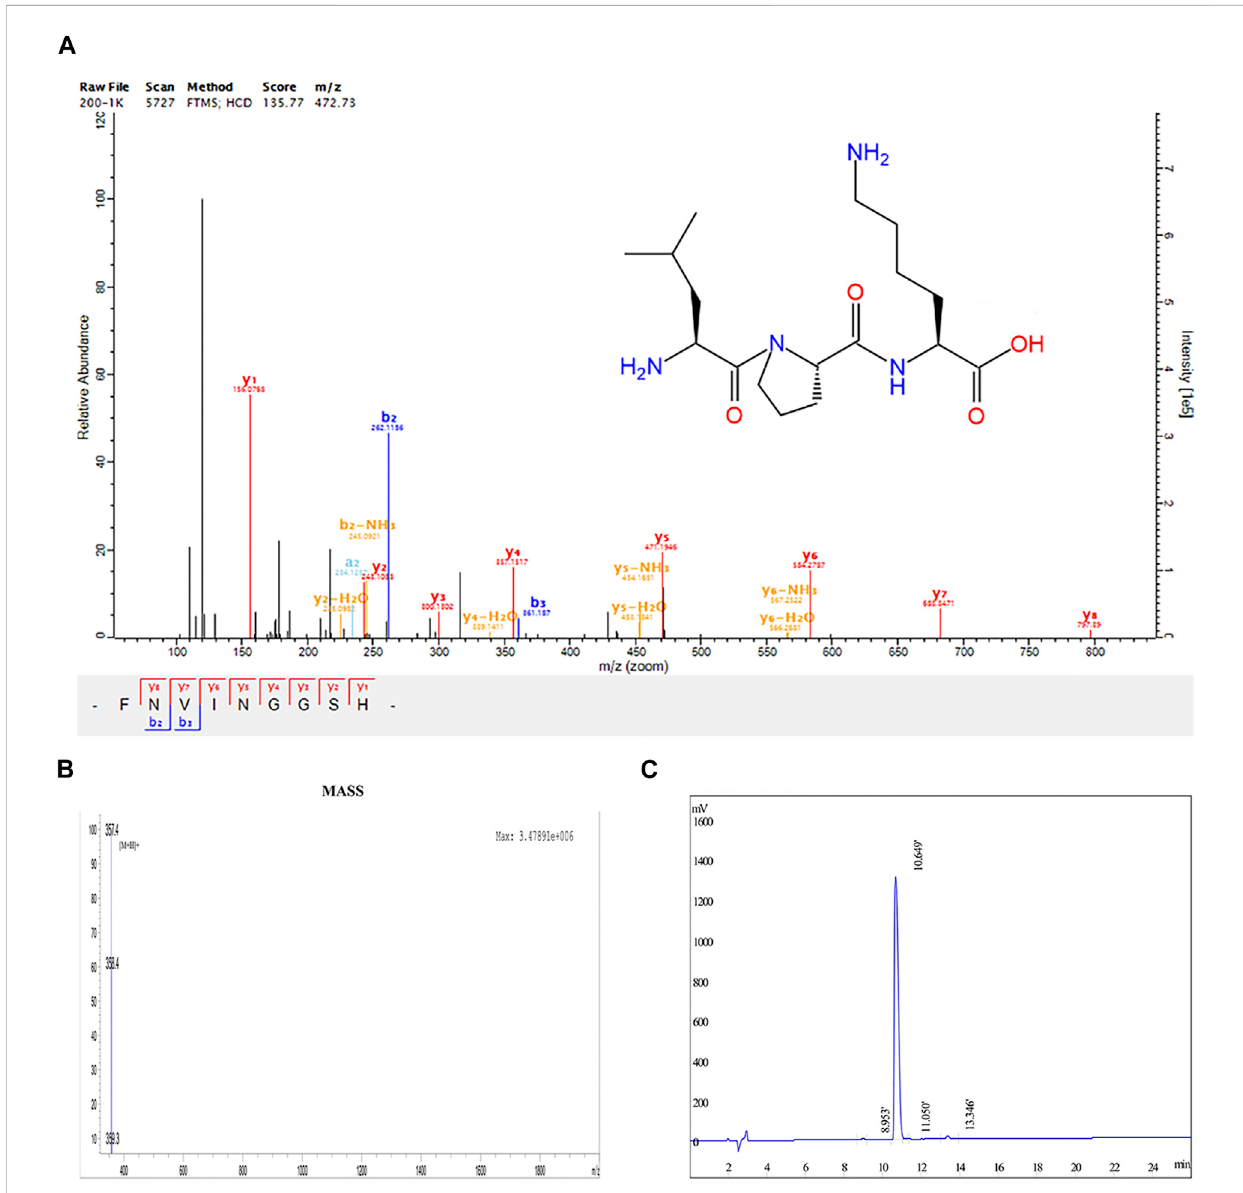
FIGURE 1 Structural determination results of LPK. (A) Chemical structure of LPK. (B) HPLC determination results of LPK. (C) Mass spectrometry results of LPK.